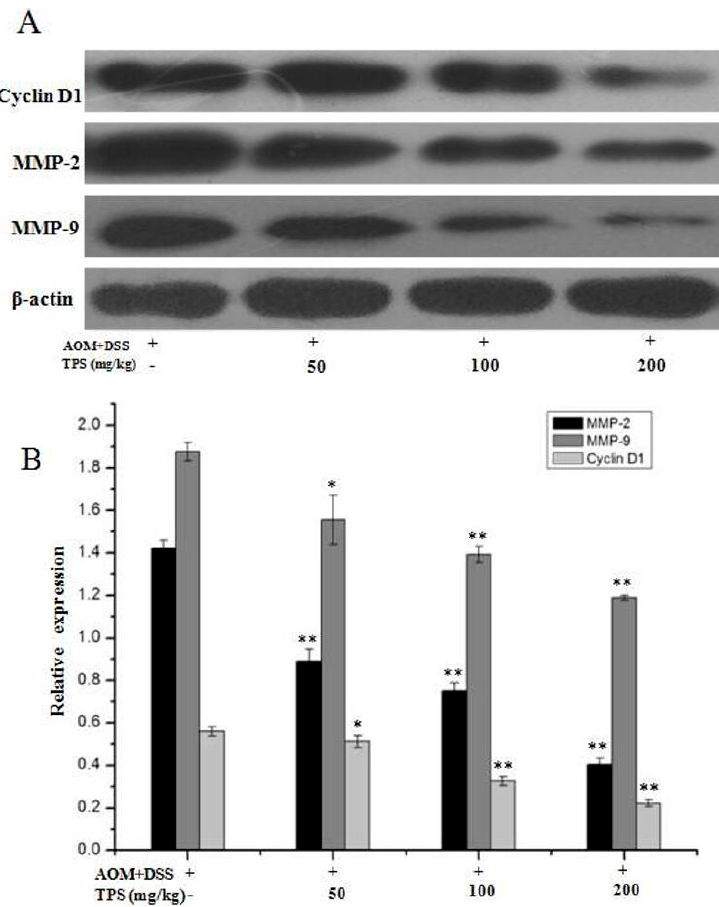
Figure 4. Protein expression levels of cyclin D1, MMP-2, and MMP-9 in AOM/DSS mice by Western blot. ( A ) Western blots were performed to see the effects of TPS on the expression of proteins cyclin D1, MMP-2, and MMP-9. ( B ) Densitometric analysis was performed to determine the relative levels of the proteins cyclin D1, MMP-2, and MMP-9. The results are expressed as mean ± SD of three independent experiments. * p < 0.05, ** p < 0.01, vs. AOM/DSS